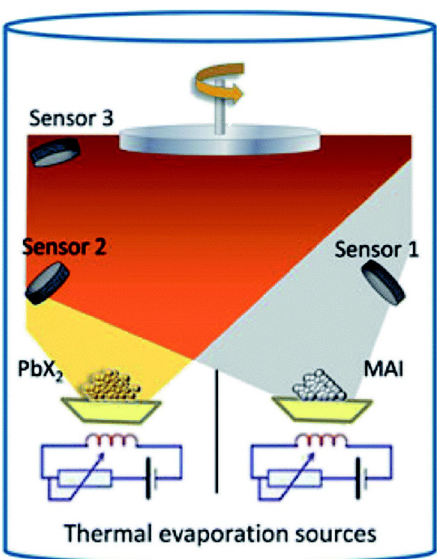
Fig. 18. – Illustration of the dual-source vacuum deposition instrument. The PbX2 (X = I, Cl) and CH3NH3I (MAI) precursors are thermally evaporated in vacuum. The deposition rate and thickness are monitored using quartz microbalances. The figure is taken from ref. [108].